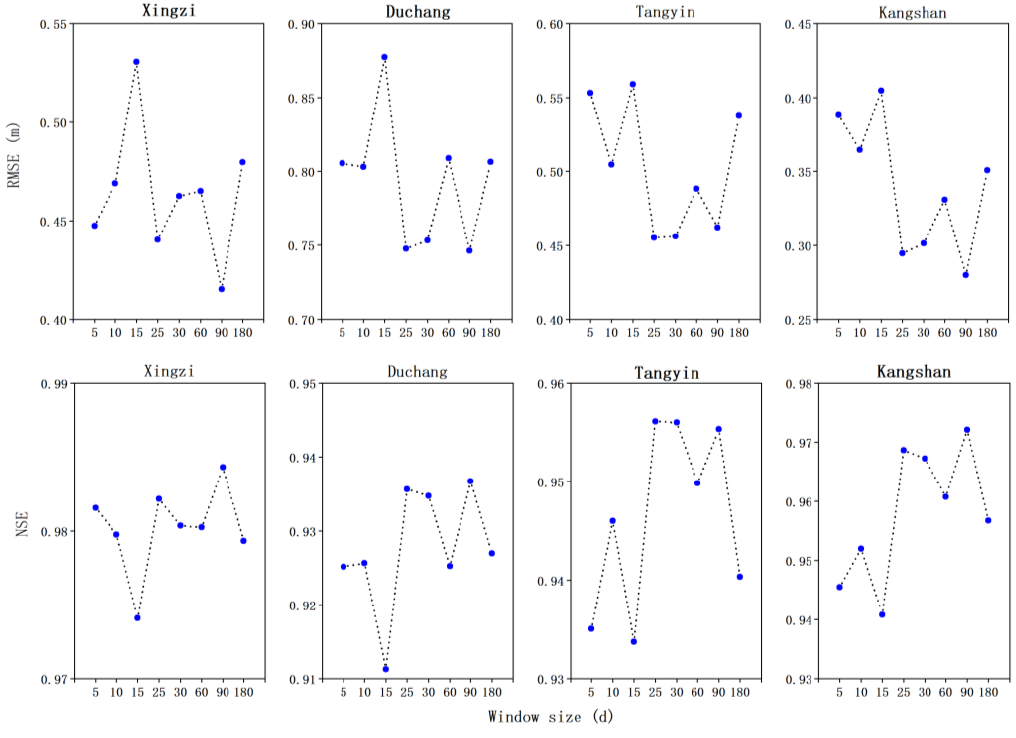
Figure 7. Simulation accuracy (RMSE and NSE) under different window sizes of Transformer model.